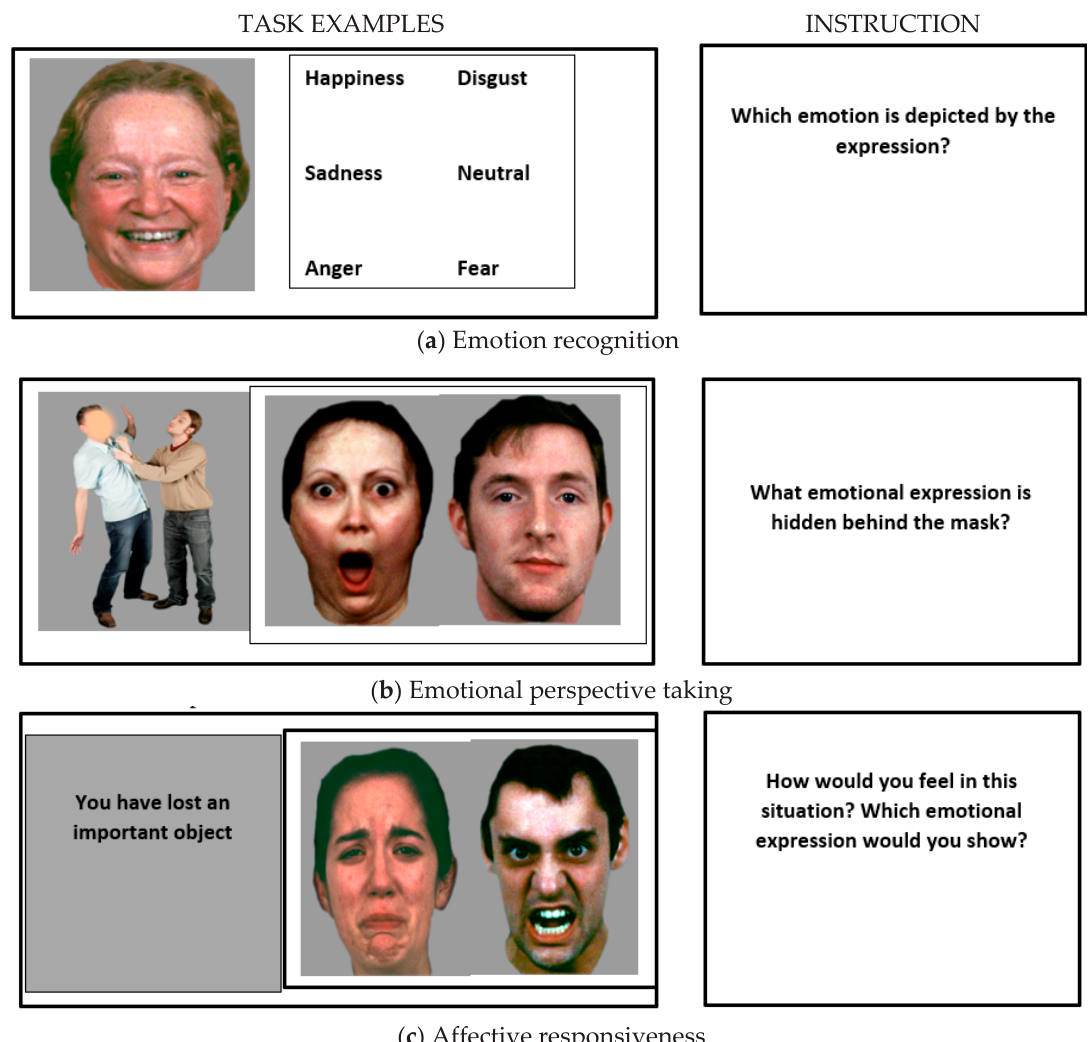
Figure 1. Illustration of the three tasks, measuring ( a ) emotion recognition, ( b ) emotional perspective taking, and ( c ) affective responsiveness as core components of the empathic ability. Task instructions are listed next to the example stimuli. Image adapted from [10].